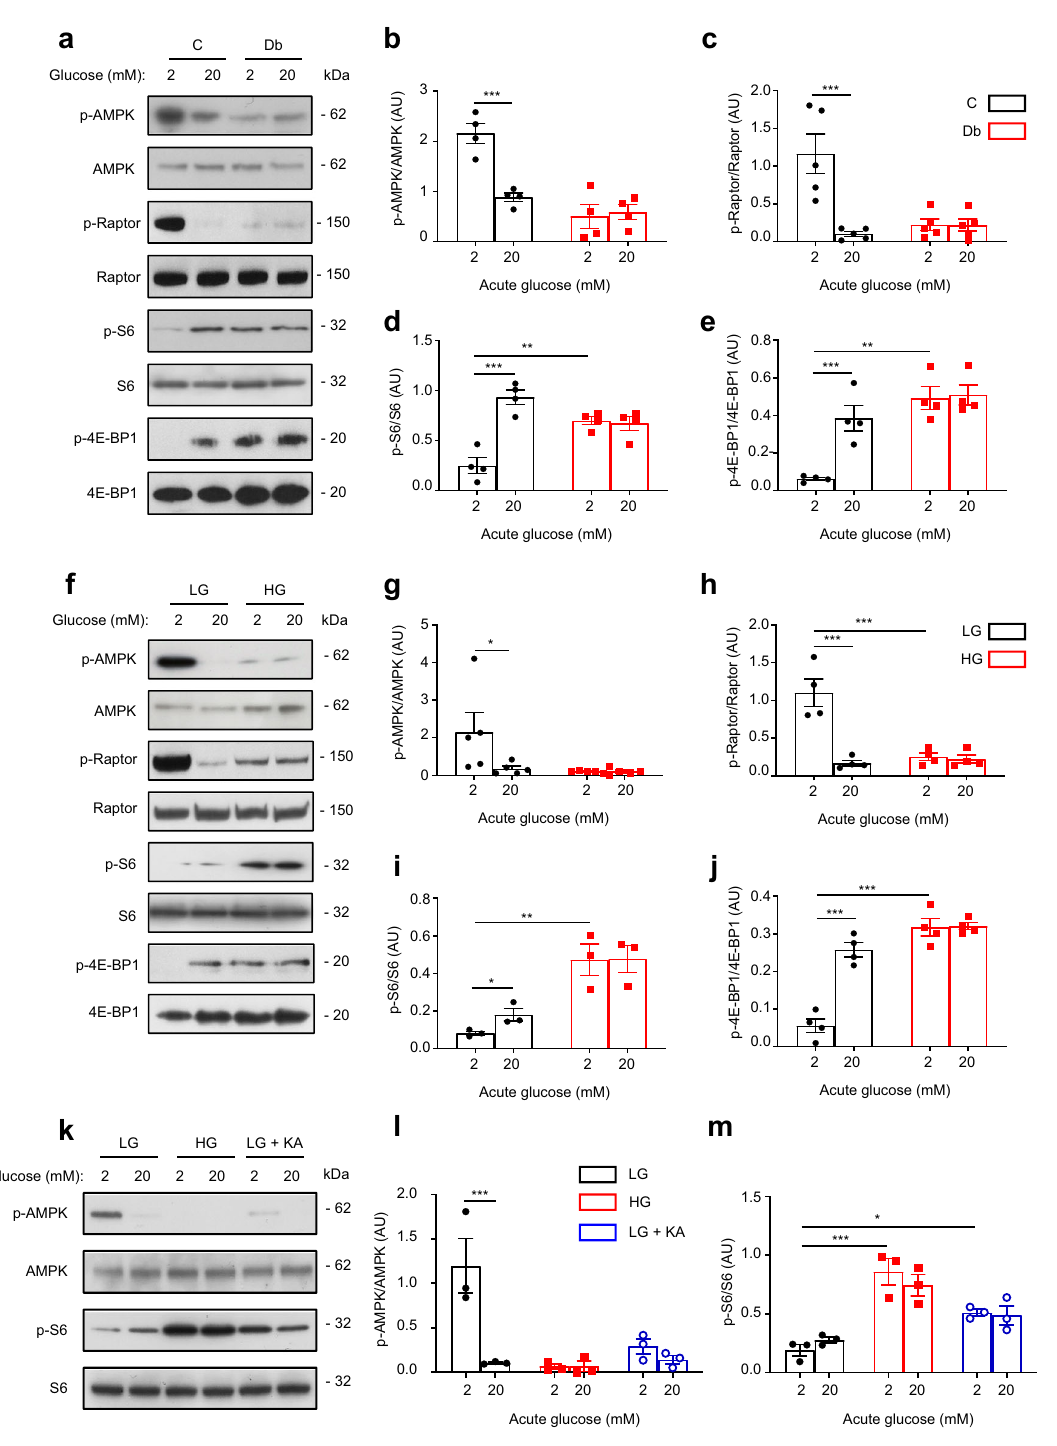
Fig. 5 | Chronic hyperglycaemia decreases AMPK and increases mTORC1 sig- nalling. a RepresentativeWesternblotof lysatesfromcontrol(C)and diabetic(Db) islets stimulated with 2mM or 20mM glucose for 1h. Phosphorylated (p) and total AMPK, Raptor, S6 and 4E-BP1. Uncropped blots in Source data. b – e Quantitative densitometry analysis of p-AMPK/AMPK ( b , n =4, 12 – 15 animals/genotype), p-Rap- tor/Raptor ( c , n =5, 14 – 17 animals/genotype), p-S6/S6 ( d , n =4, 12 – 15 animals/gen- otype) and p-4E-BP1/4E-BP1 ( e , n =4, 12 – 15 animals/genotype). Control, black bars. Diabetic, red bars. f Representative Western blot of lysates from LG-cells and HG- cells stimulated with 2mM or 20mM glucose for 1h. Phosphorylated (p) and total AMPK, Raptor, S6 and 4E-BP1. Uncropped blots in Source data. g – j Quantitative densitometry analysis of p-AMPK/AMPK ( g , n =5), p-Raptor/Raptor ( h , n =4